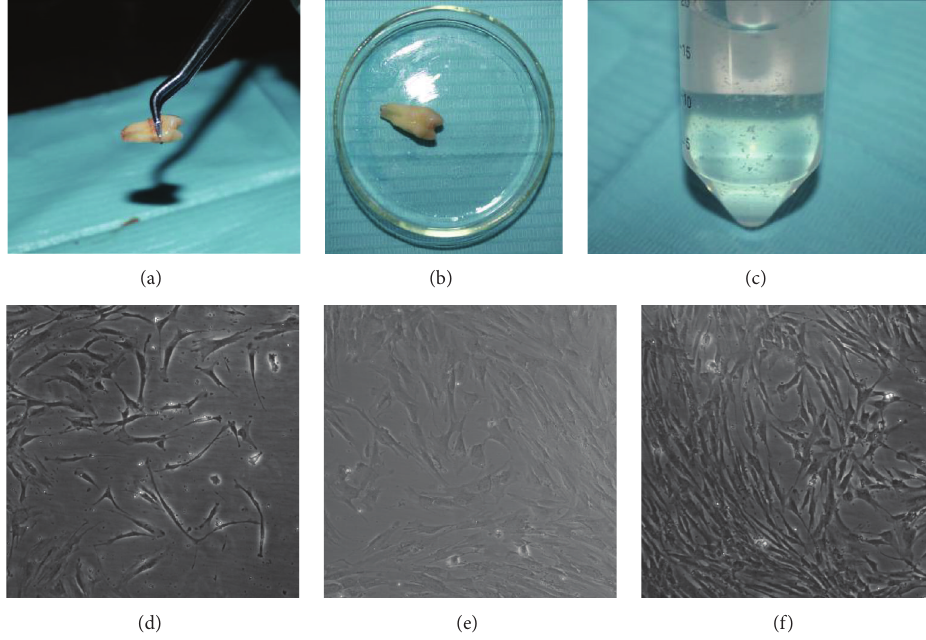
Figure 2: Primary culture of hPDLSCs ((a), (b), and (c)). (d) 7d ( × 100), (e) 10d ( × 100), and (f) 14d ( × 40).